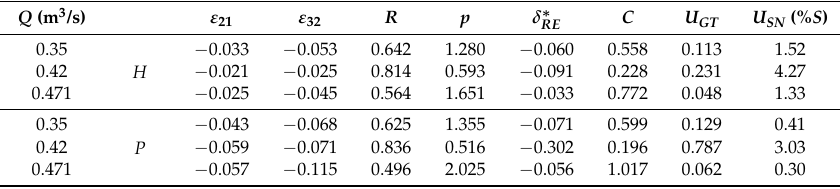
Table 5. Results of the numerical uncertainties at different flow